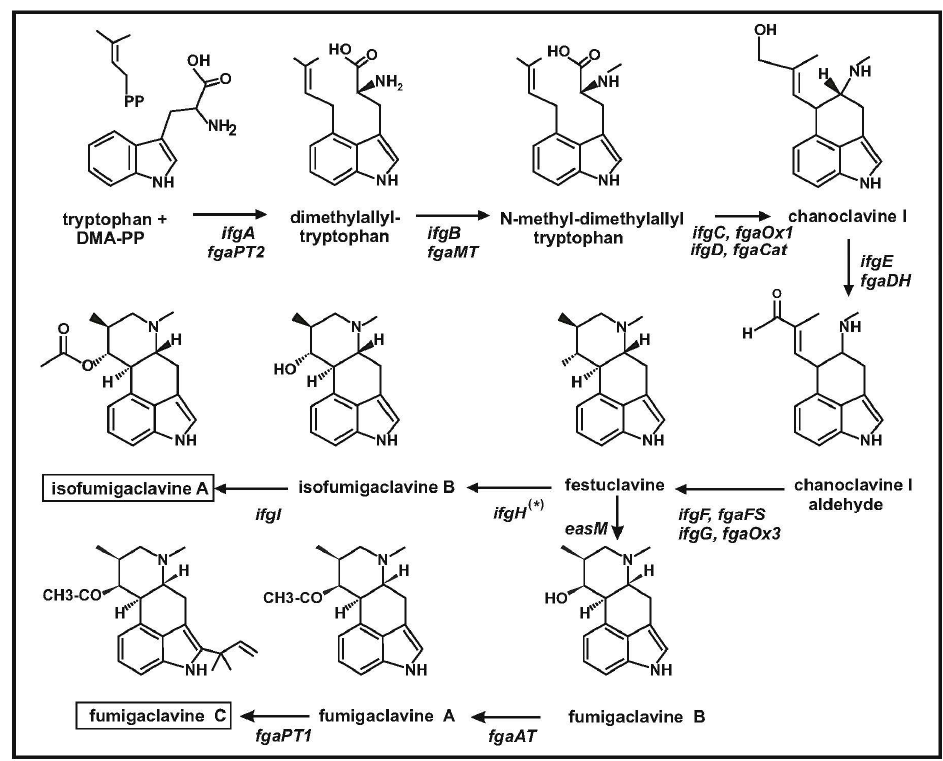
Figure 3. Biosynthetic pathway of isofumigaclavine A in P. roqueforti and fumigaclavine C in N. fumigata . The ifgH gene for the festuclavine hydroxylase, labelled with an asterisk, is not located in any of the two isofumigaclavine clusters of P. roqueforti . The names of the genes in N. fumigata are indicated below the names of the P. roqueforti genes.